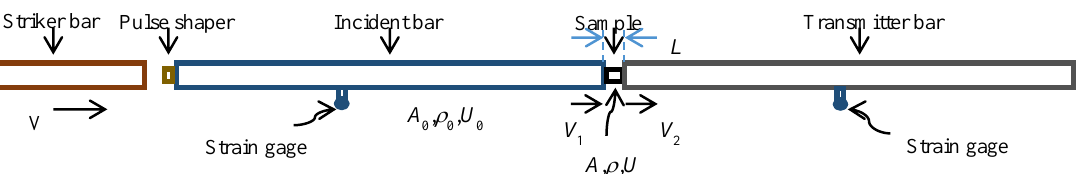
Table 2. The parameters of resin honeycombs.